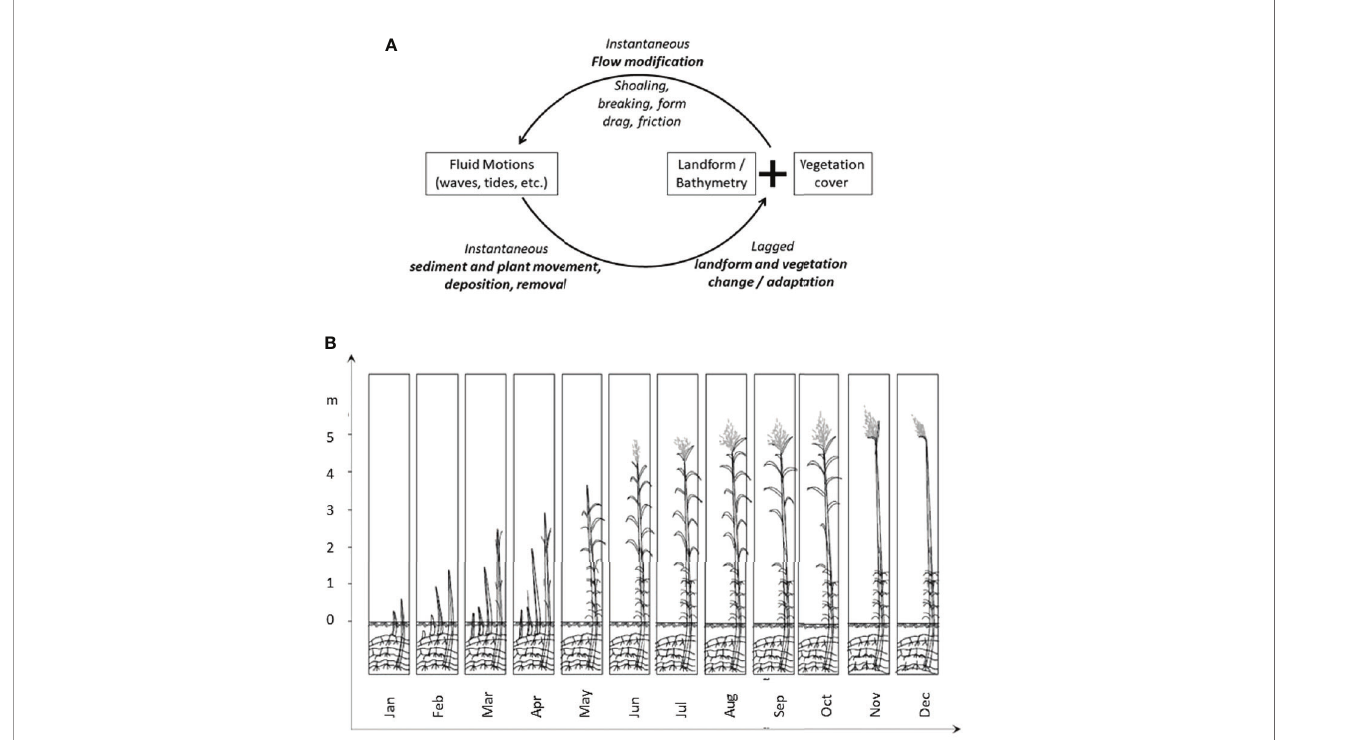
FIGURE 1 | (A) Biomorphodynamic feedback on shallow coasts (adapted from: Cowell and Thom, 1999; and Möller, 2012) and (B) Evolution of a reedbed during the year as represented schematically by Rudescu et al. (1965) and observed at the fi eld sites in this study (see Figure 3 for locations and note reed decay into the winter and re-growth into